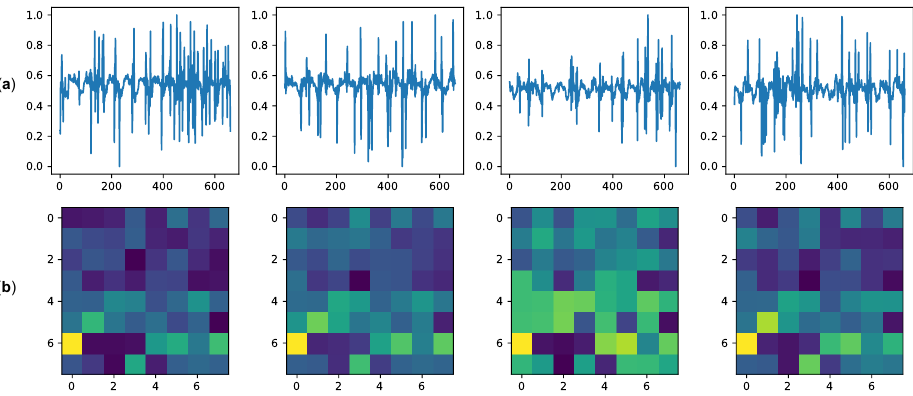
Figure 13. Examples of latent space generation. Examples of radar phase input ( a ) and generated latent spaces ( b ), size 32, are shown. The latent spaces are obtained after the model generalization training. Each 8 x 8 representation consists of the mean values µ and the standard deviations σ . Starting from the top of the representations toward the right, the first 32 pixels represent µ values, while the last 32 are those of σ